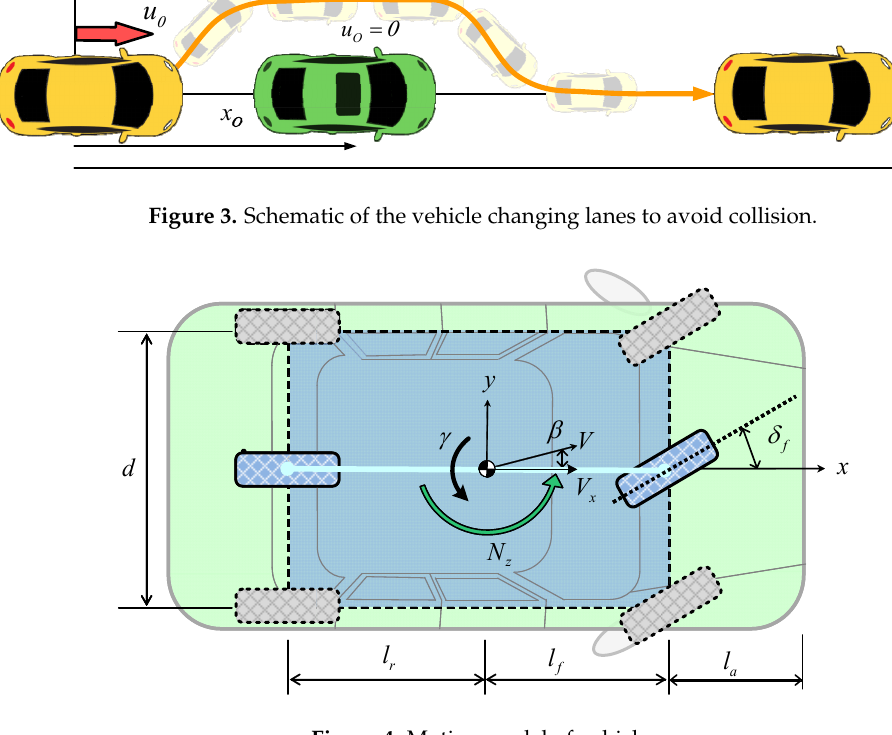
Figure 4. Motion model of vehicle.